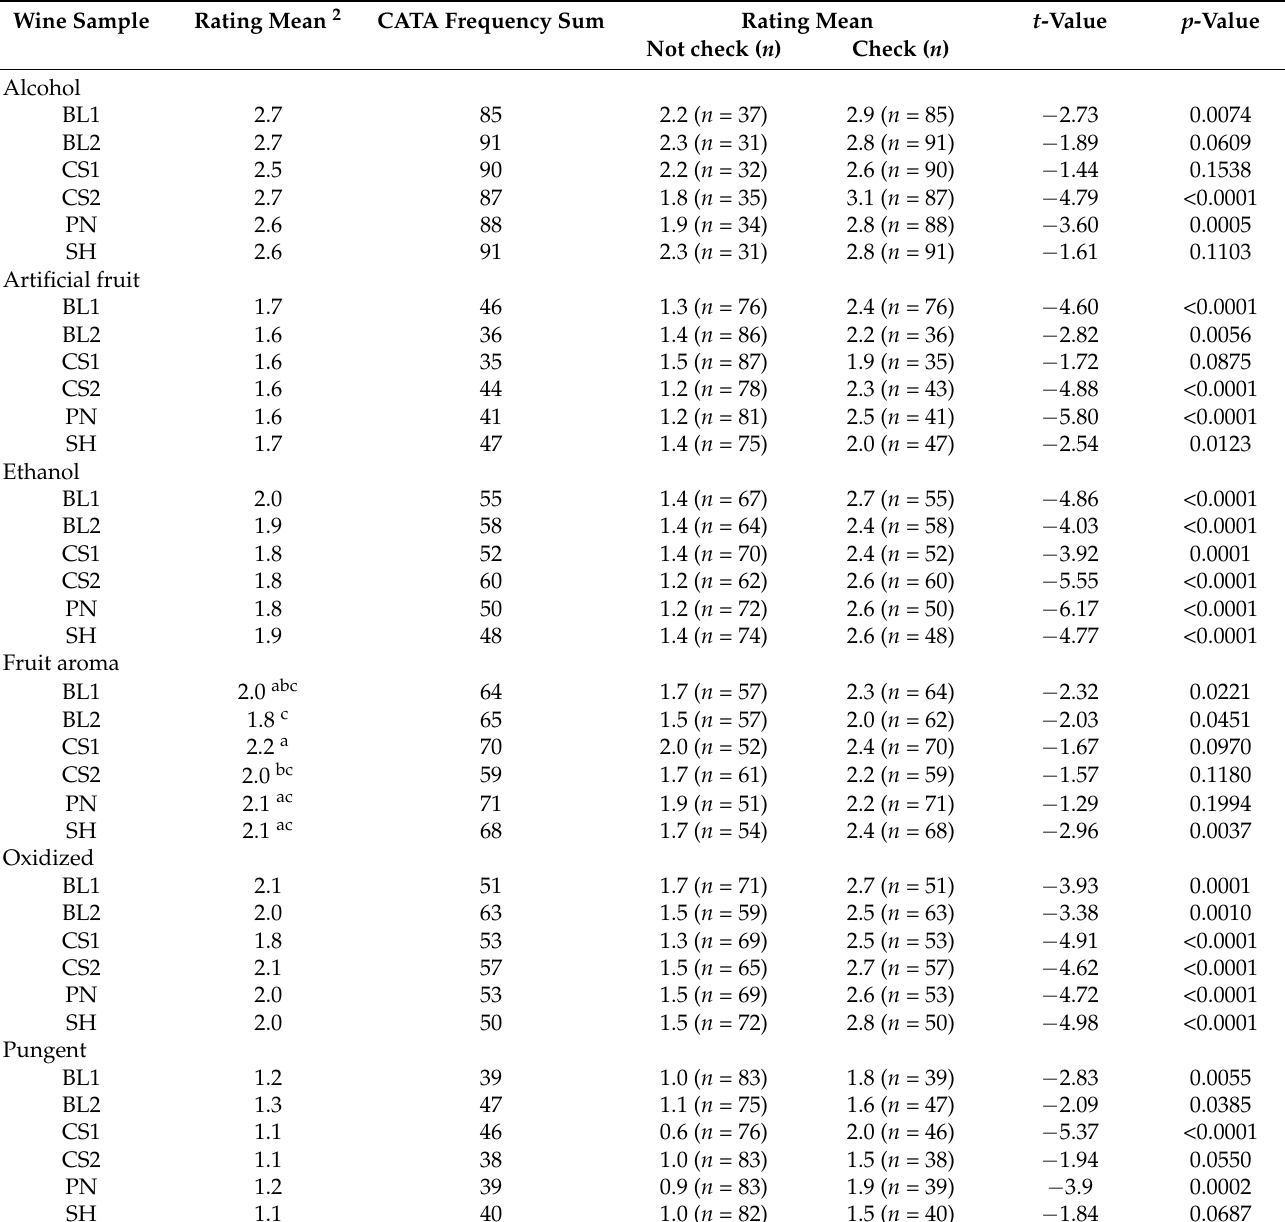
Table 3. The mean results of intensity rating and summation of frequencies from the CATA questionnaire for the six most selected terms ( n = 122) 1